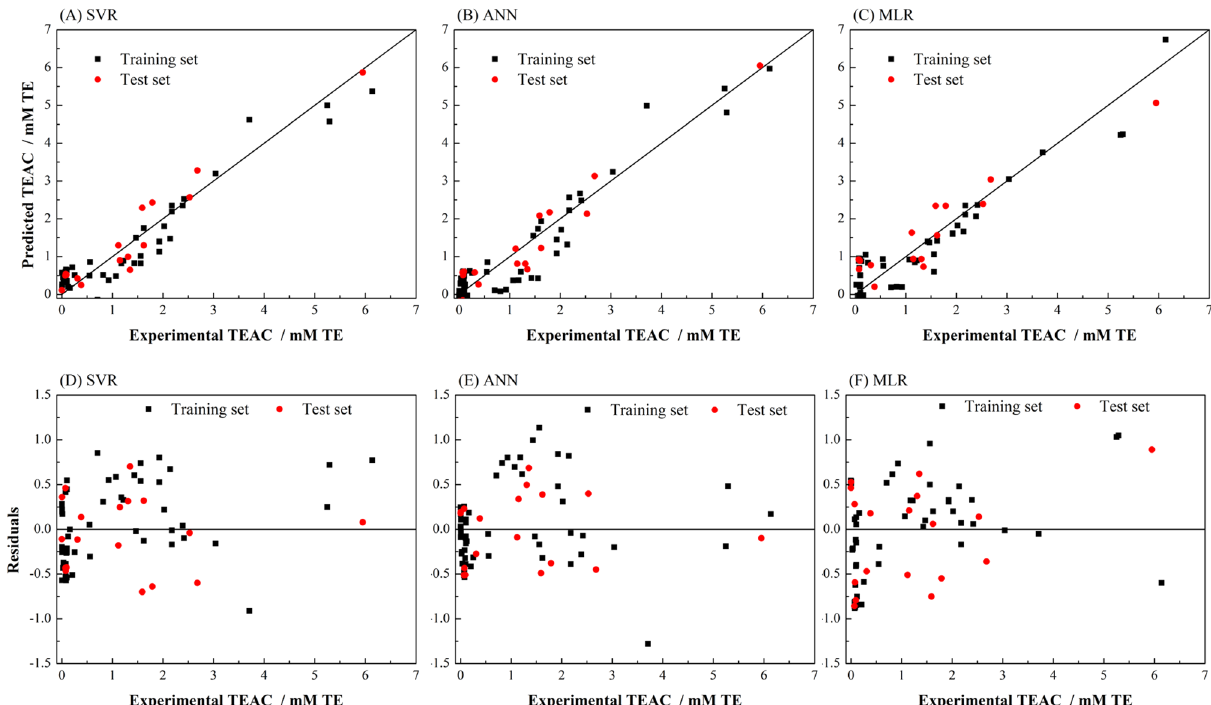
Figure 2. Experimental vs predicted activities of TEAC in LOOCV test and external test set of ( A ) SVR (using RBF kernel), ( B ) ANN, and ( C ) MLR. The plot of predicted residuals vs experimental values of TEAC of ( D ) SVR, ( E ) ANN and ( F )